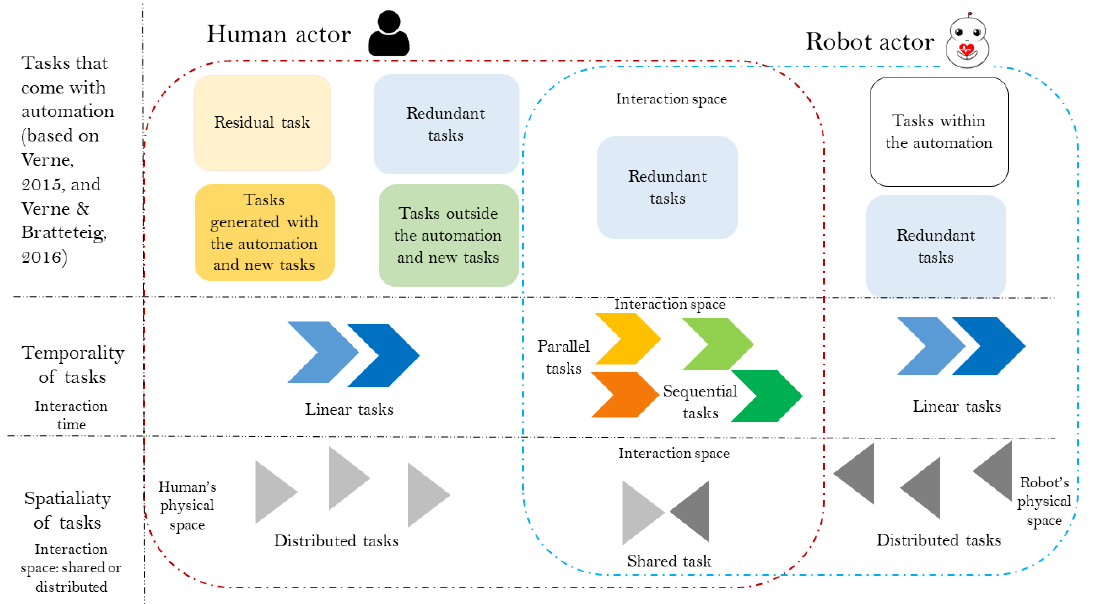
Figure 5. Framework: division of work tasks between humans and robots.